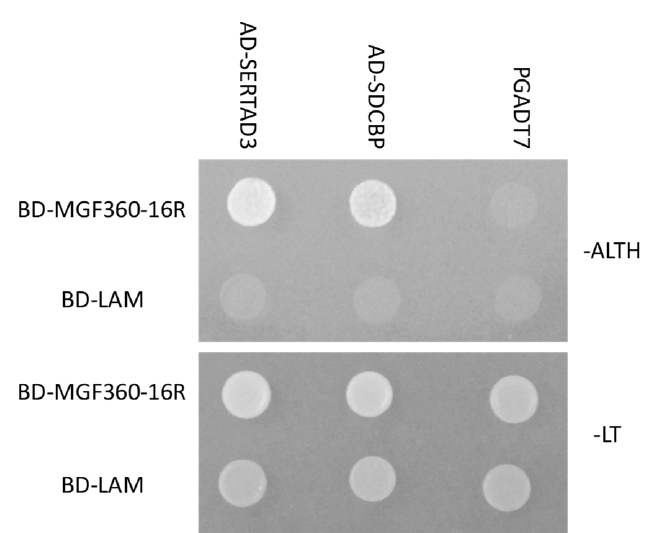
Viruses 2020 , 12 , x FOR PEER REVIEW 8 of 15